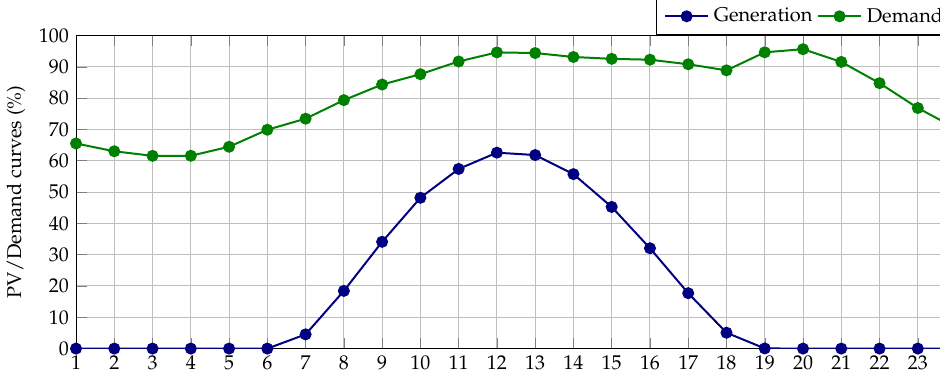
Figure 3. Behavior of the generation and demand curves for the municipality of Medellín.